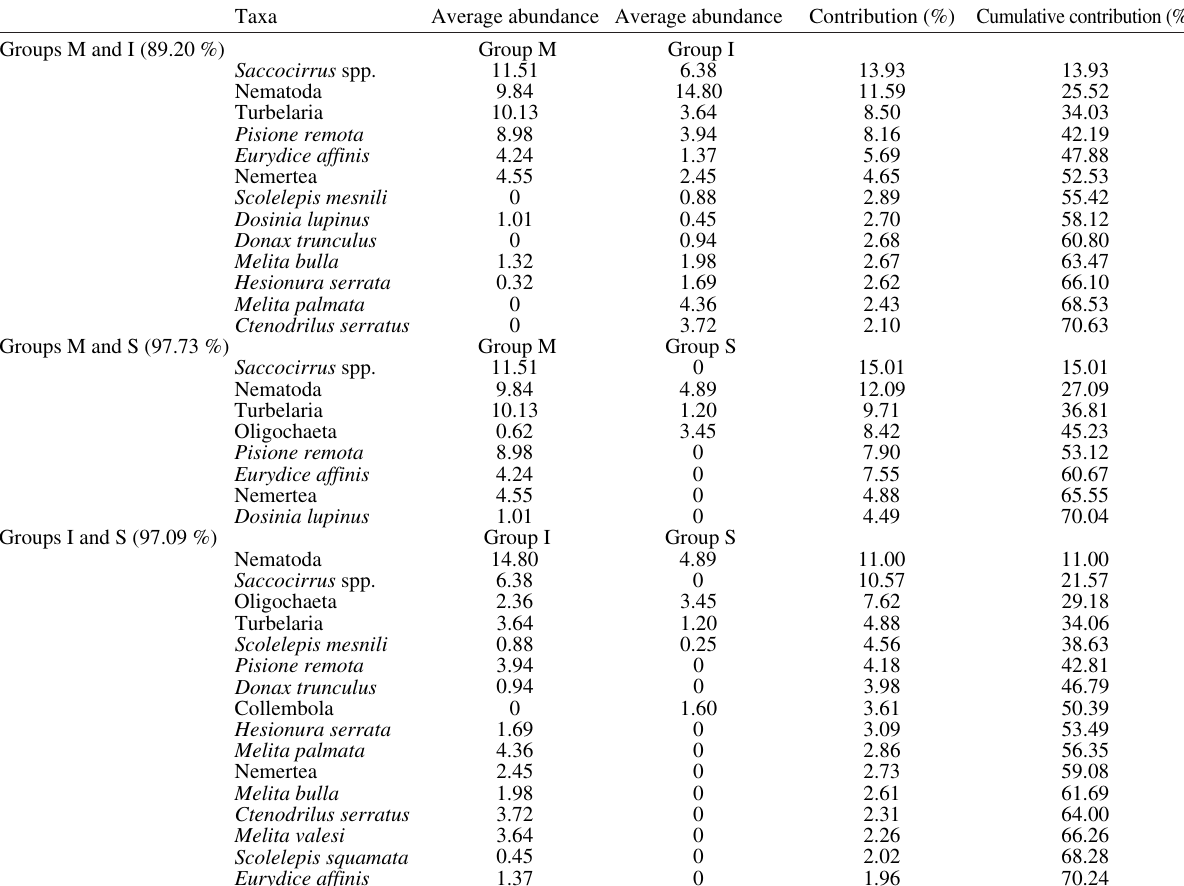
+ Protodrillus s p. + Siphonoecetes dellavallei + + Richness Table 7. – Contributions and average abundances of species responsible for 70% of dissimilarities (SIMPER analysis) between groups (su- pralittoral (S), mediolittoral (M), and infralittoral (I) levels) based on total macrofaunal composition. Total dissimilarity between groups is included. Taxa Average abundance Average abundance Contribution (%) Cumulative contribution (%) Groups M and I (89.20 %) Group